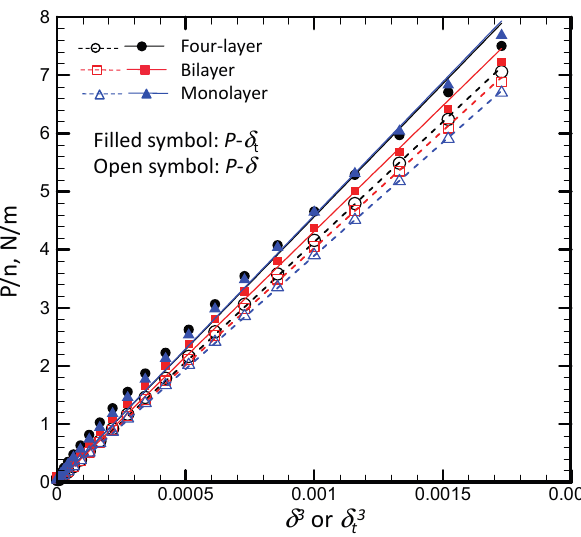
Figure 16. The relationship between the normalized indentation load (P / n) and the normalized indentation displacement ( ( δ n = 1–4.